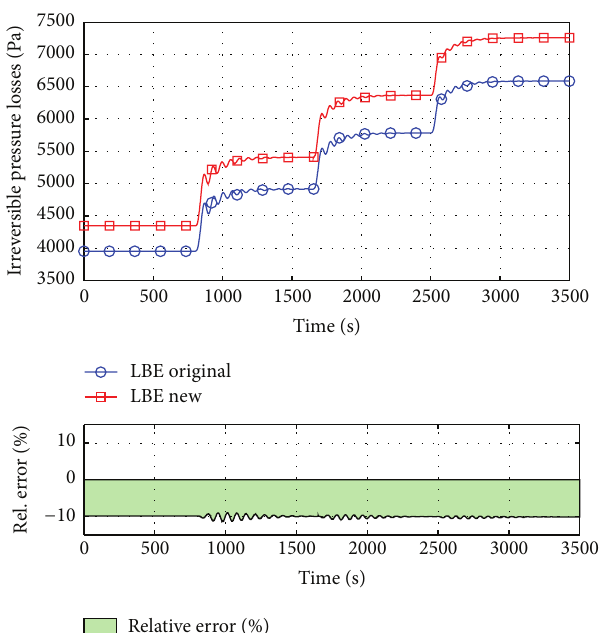
Figure 25: LBE system irreversible pressure losses, original versus new “tpf”